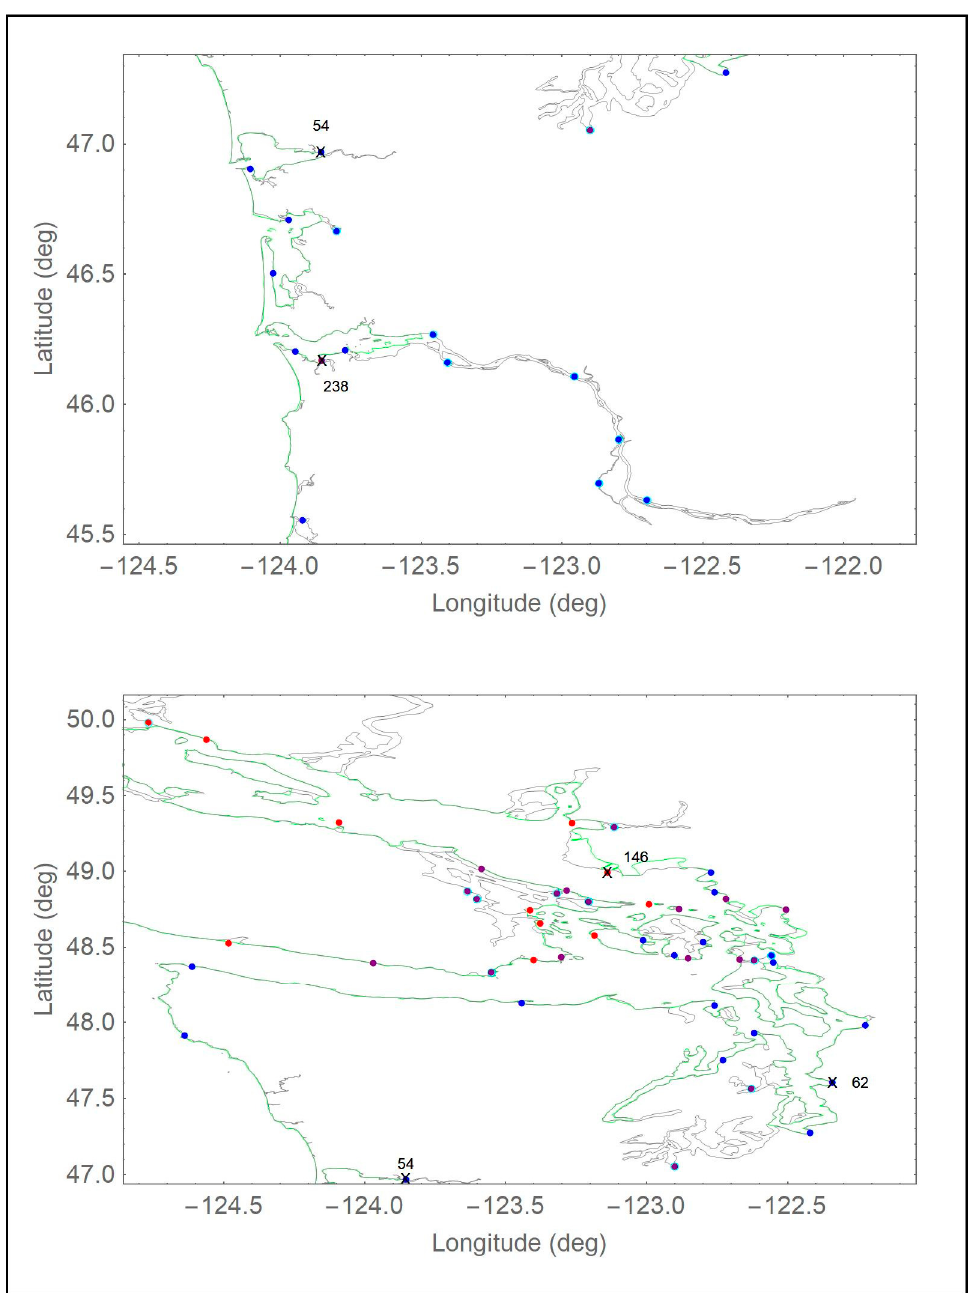
Figure A3. Location of validation stations: Columbia River and Puget Sound.